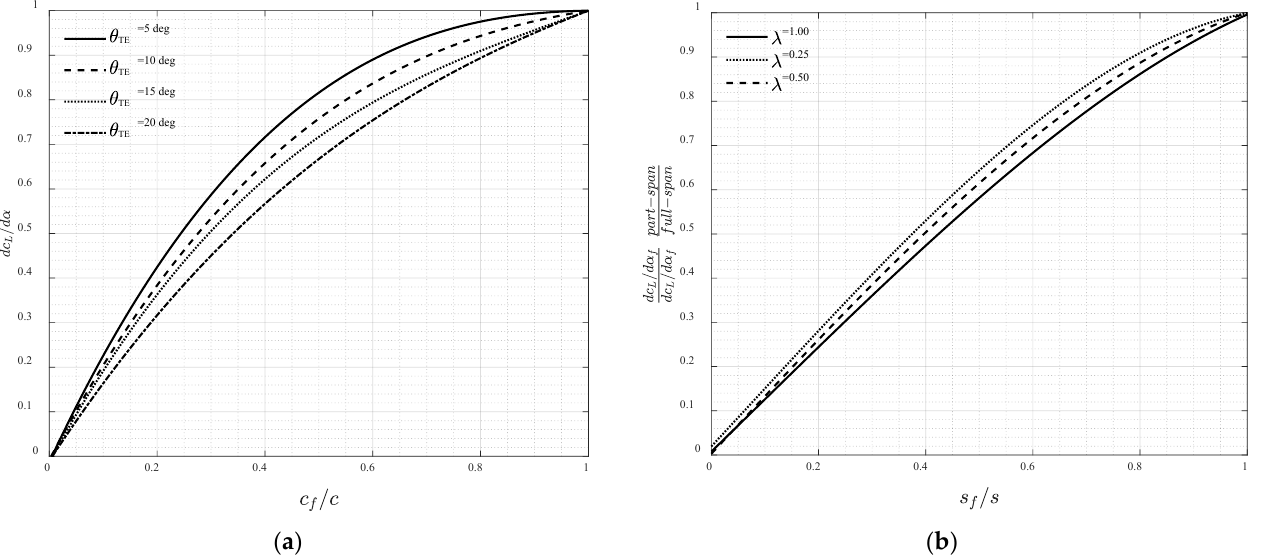
Figure 8. Flapped control surfaces—effect on lift [61]. ( a ) Chord-wise extent and trailing edge angle. ( b ) Span-wise extent and taper ratio.